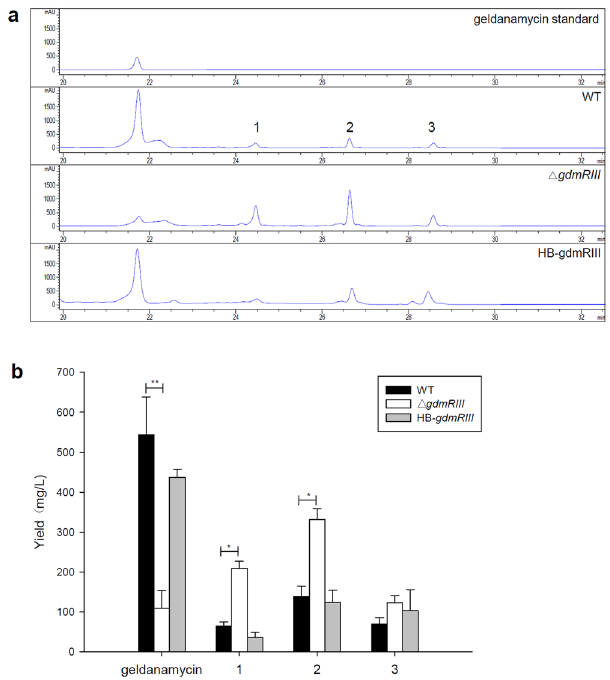
Figure 1. Analyses of the fermentation products of the wild-type strain, the Δ gdmRIII mutant, and the Δ gdmRIII complementation strain HB-gmdRIII. ( a ) HPLC analyses of the fermentation products; ( b ) the yield of compounds. 1 , 2 , and 3 stand for three compounds with retention time of 24.4 min, 26.6 min, and 28.4 min, respectively. Values are the average of three independent experiments, each with three replicates. Error bars indicate the standard deviation of means. The comparisons are made relative to the wild type in all instances. * p < 0.05, ** p < 0.01 by paired samples